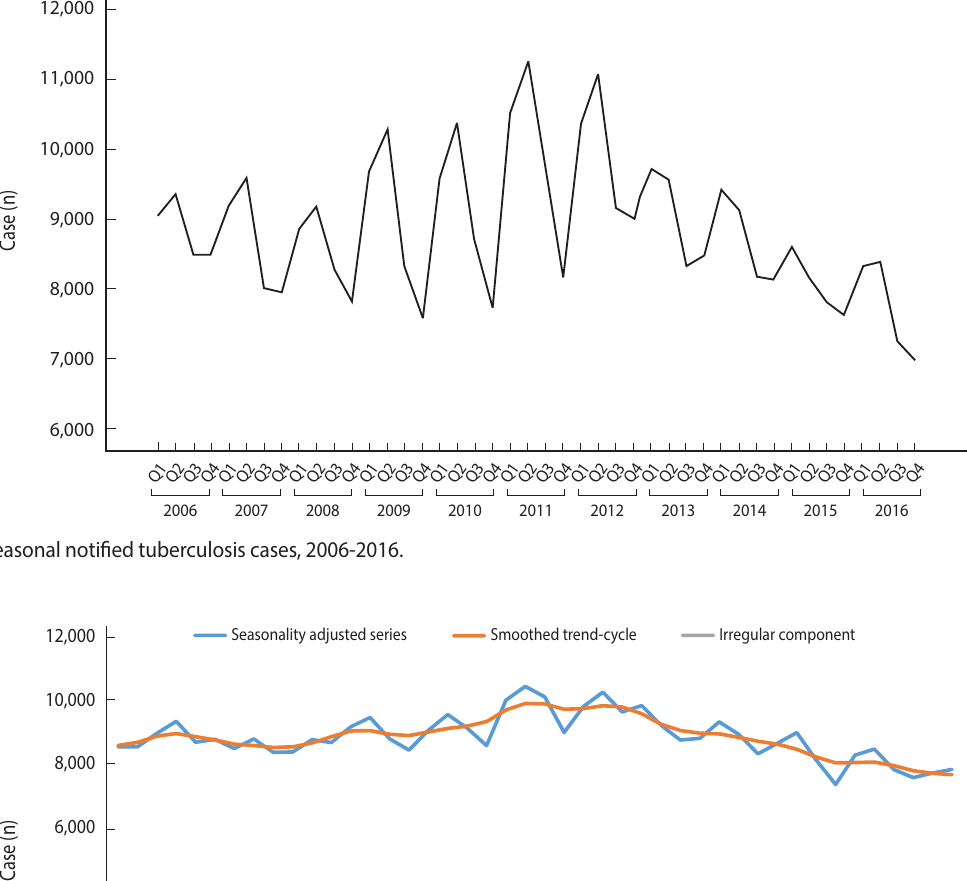
Figure 2. Time series decompositions of tuberculosis cases